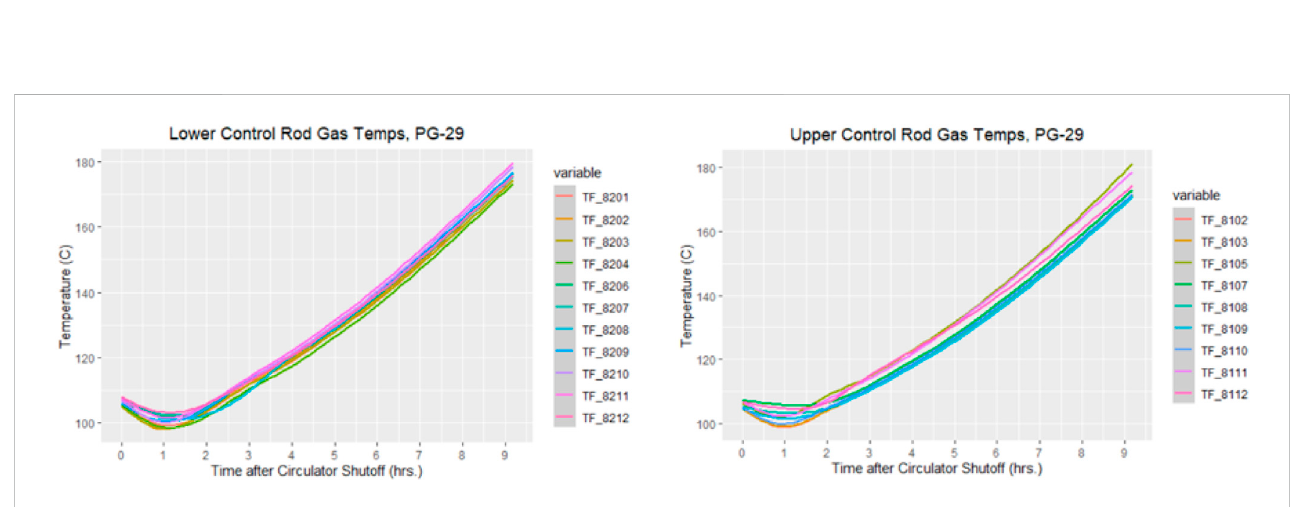
Frontiers in Energy